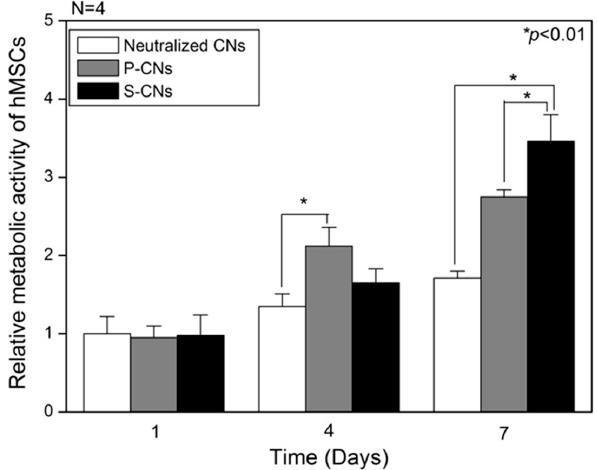
Figure 4. The relative metabolic activity of hMSCs on neutralized CNs, P-CNs and S-CNs in conditioned (serum free) media over the course of seven days.